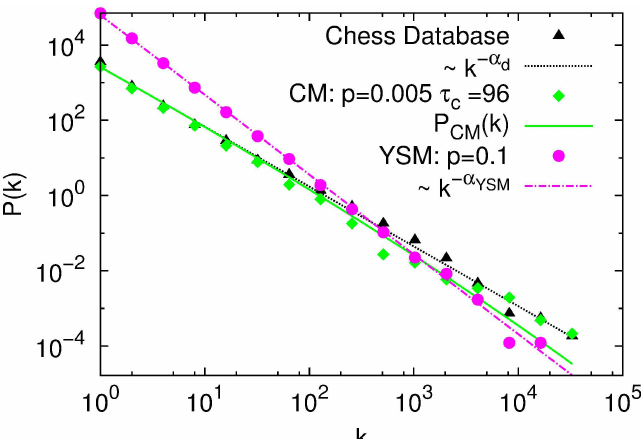
Fig 3. Log-log plot of the distribution of popularities: measuredin the database (black triangles), fitted with P ( k ) / k − α and exponent α d = 1.59 ± 0.02 ( R 2 = 0.997) (dotted black line); generated with CM, p = 0.005 and τ c = 96 (green diamonds) fitted with P CM ( k ) (see Eq (3)) with parameter Ω = 1.5 ± 0.3 (full green line); and generated with YSM model, p = 0.1 (magenta circles) and fitted with P ( k ) and exponent α YSM = 2.12 ± 0.03 ( R 2 = 0.997) (magenta point dashed line).